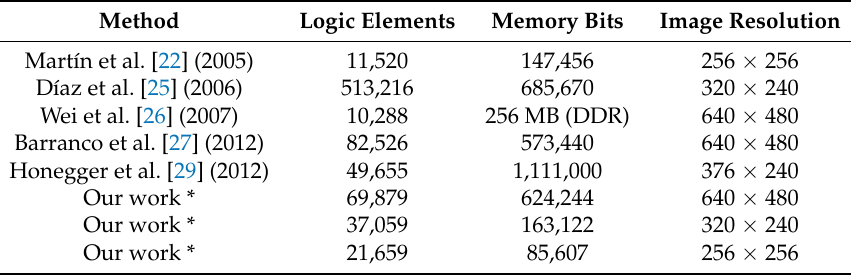
Table 2. Hardware resource